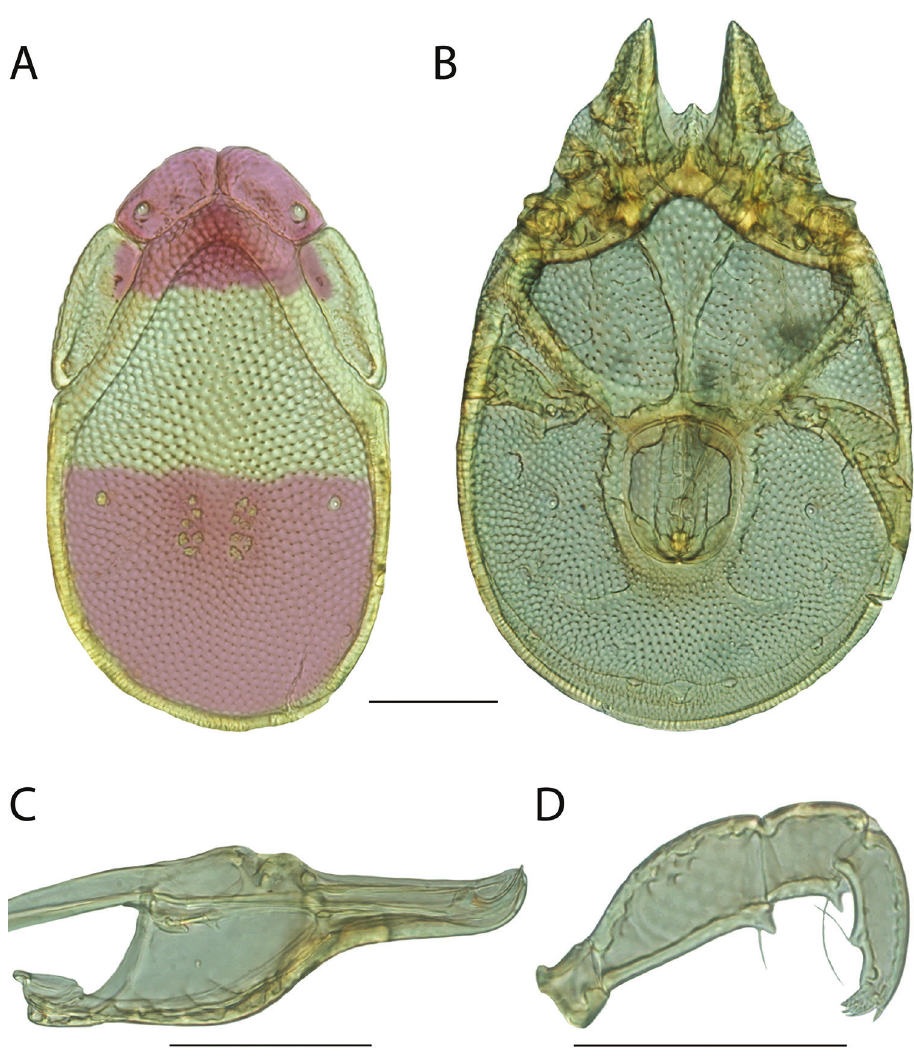
Figure 69. Torrenticola elongata sp. n. male: A dorsal plates, coloration added B venter (legs removed) C subcapitulum D pedipalp (setae not accurately depicted). Scale = 100 µm.